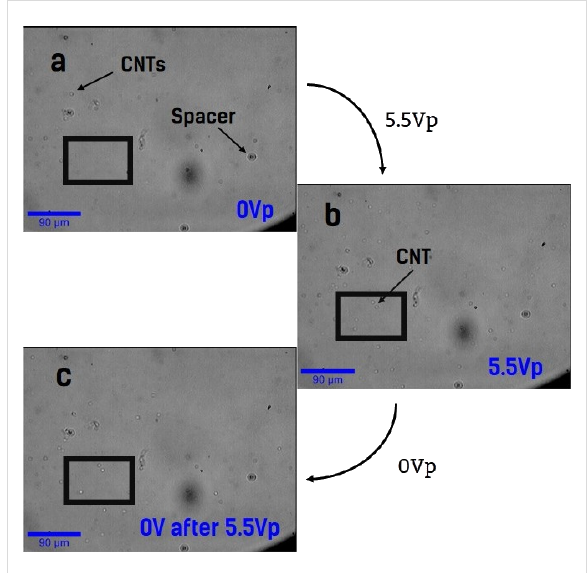
Figure 6: Cell images under microscopic study during a complete off–on–off voltage cycle. Sample surface (a) prior to voltage applica- tion, (b) at 5.5 V p and (c) at 0 V p after several off–on (maximum 5.5 V p ) cycles. The squares highlight four points: from the (b) to the (c) condition, one of them relaxes while the other three do not recover the original state.